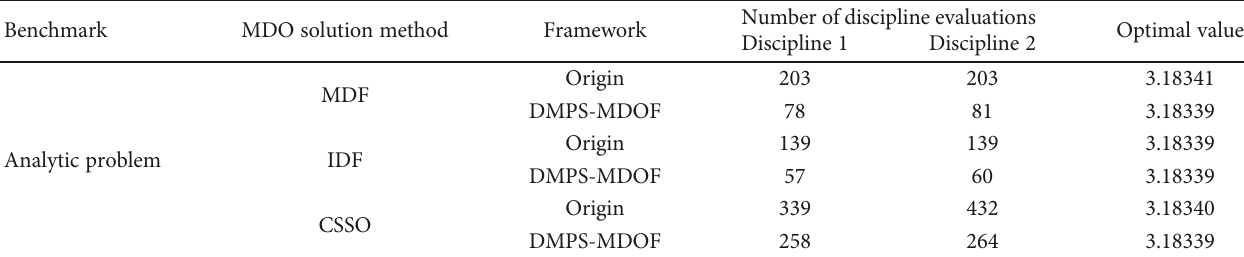
Table 3: Result comparison of the analytic problem.